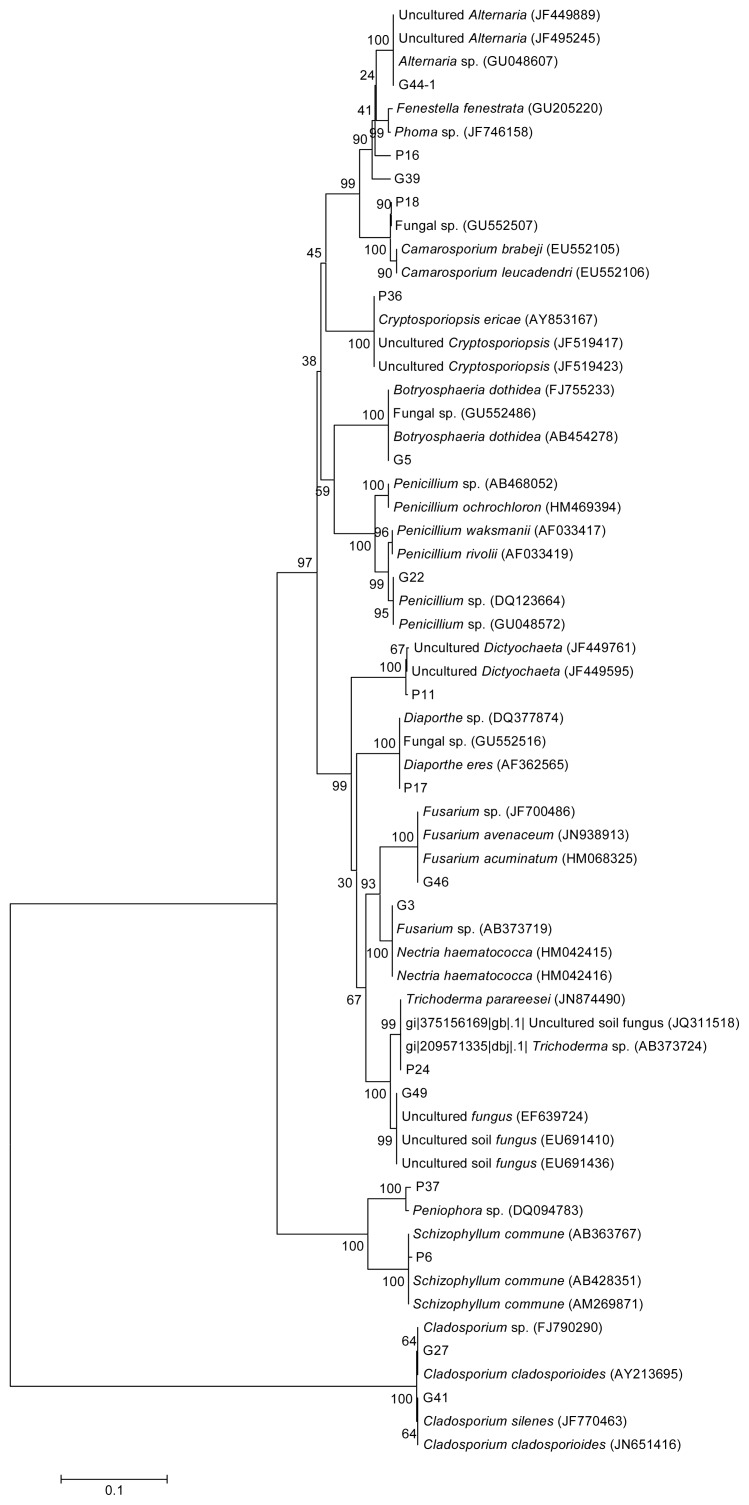
A 28S rDNA sequence-based phylogenetic tree constructed using the neighbor-joining method. Scale bar represents 10% estimated sequence divergence. Numbers in the branches indicate bootstrap values (percentages for 1000 replicates).